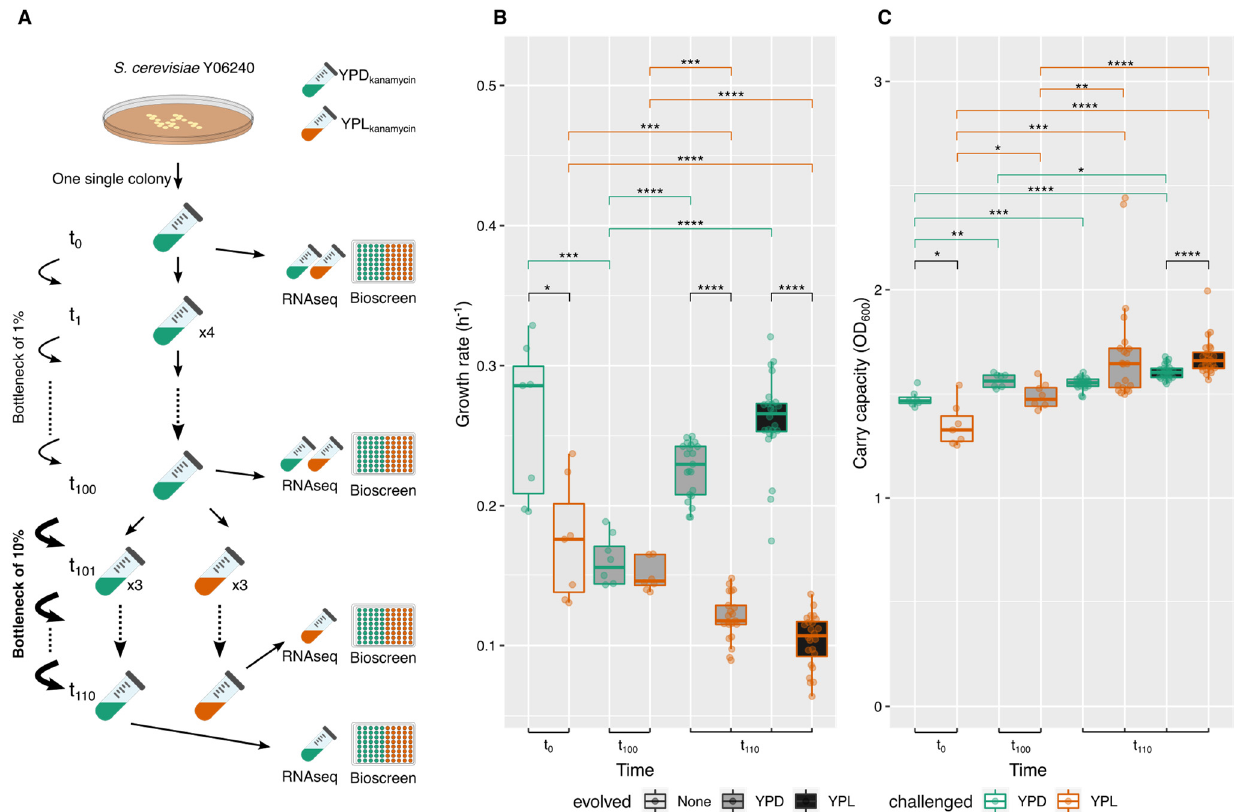
Figure 1. Saccharomyces cerevisiae laboratory evolution under diversification and adaptation to YPL and phenotypic effects on growing parameters. ( A ) Scheme of experimental evolution setup, with 1% bottlenecks during the first 100 passages (population diversification stage), and adaptive laboratory evolution to YPL or YPD under 10% population bottlenecks for additional 10 passages; ( B ) Growth rate (r, in h − 1 , as inferred from Growthcurver) for each time point and lines series, with the indication of the evolved and challenged media, note that the t 0 populations were not evolved, but reared in YPD medium; ( C ) Carrying capacity (k), as maximum OD 600 (as inferred from Growthcurver) for each time point and lines series, following the same criteria as in ( B ). Statistical differences among means were determined with *, **, *** or **** when the probabilities are p < 0.05, p < 0.005, p < 0.001, and p < 0.0001, respectively, using a Wilcoxon rank test.